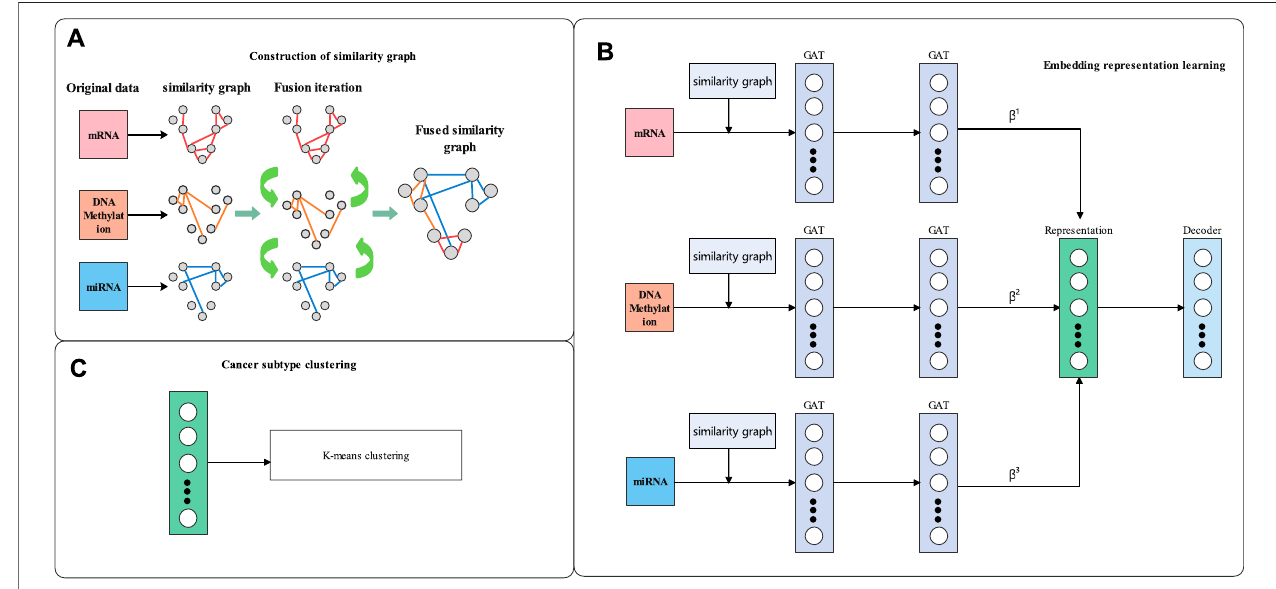
FIGURE 1 | Work fl ow of multiGATAE. (A) Construction of similarity graph. (B) Embedding representation learning. (C) Cancer subtype